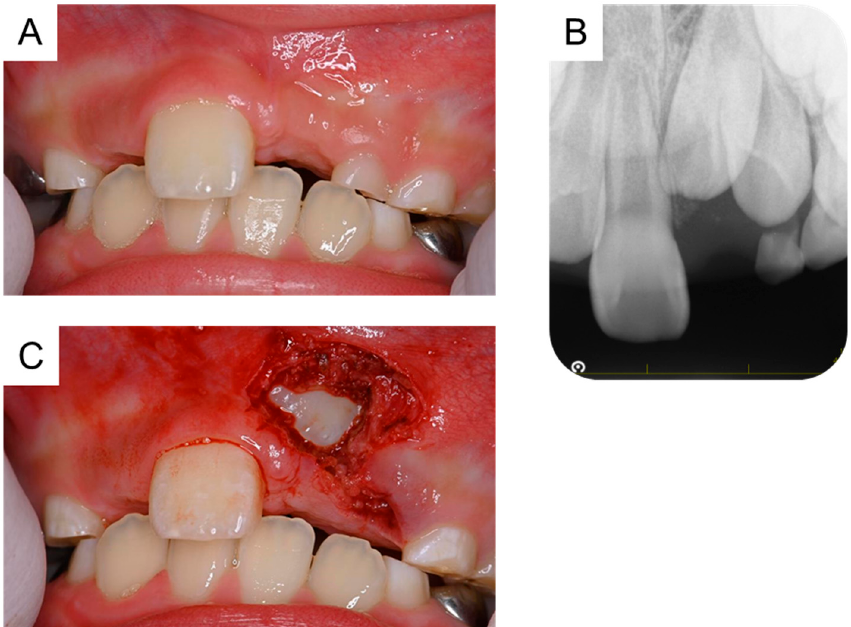
Figure 5. Fenestration of the maxillary left central incisor. ( A ) Intraoral photograph and ( B ) periapical radiograph after the extraction of the third supernumerary tooth at the age of 8 years and 9 months. ( C ) Intraoral image just after fenestration of the maxillary left central incisor at the age of 8 years and 9 months.